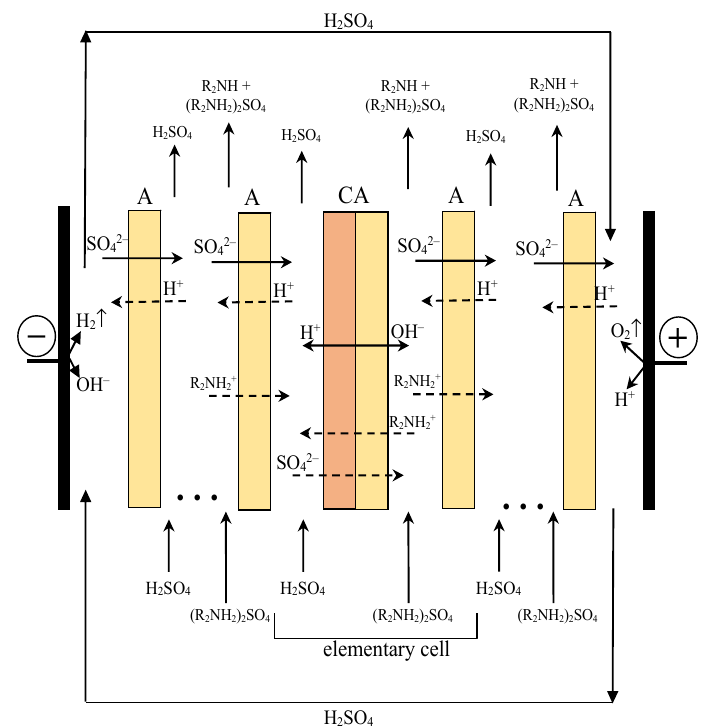
Figure 4. Scheme of a membrane stack of an electrodialyzer designed for the production of diethylamine and sulfuric acid from a diethylammonium sulfate solution. The solid arrows show the fluxes of ions transferred across the membranes, while passing an electric current through the electrodialyzer. The dashed lines show undesirable processes in the membrane stack of the electrodialyzer. The measurements were carried out in a galvanodynamic mode in a current density